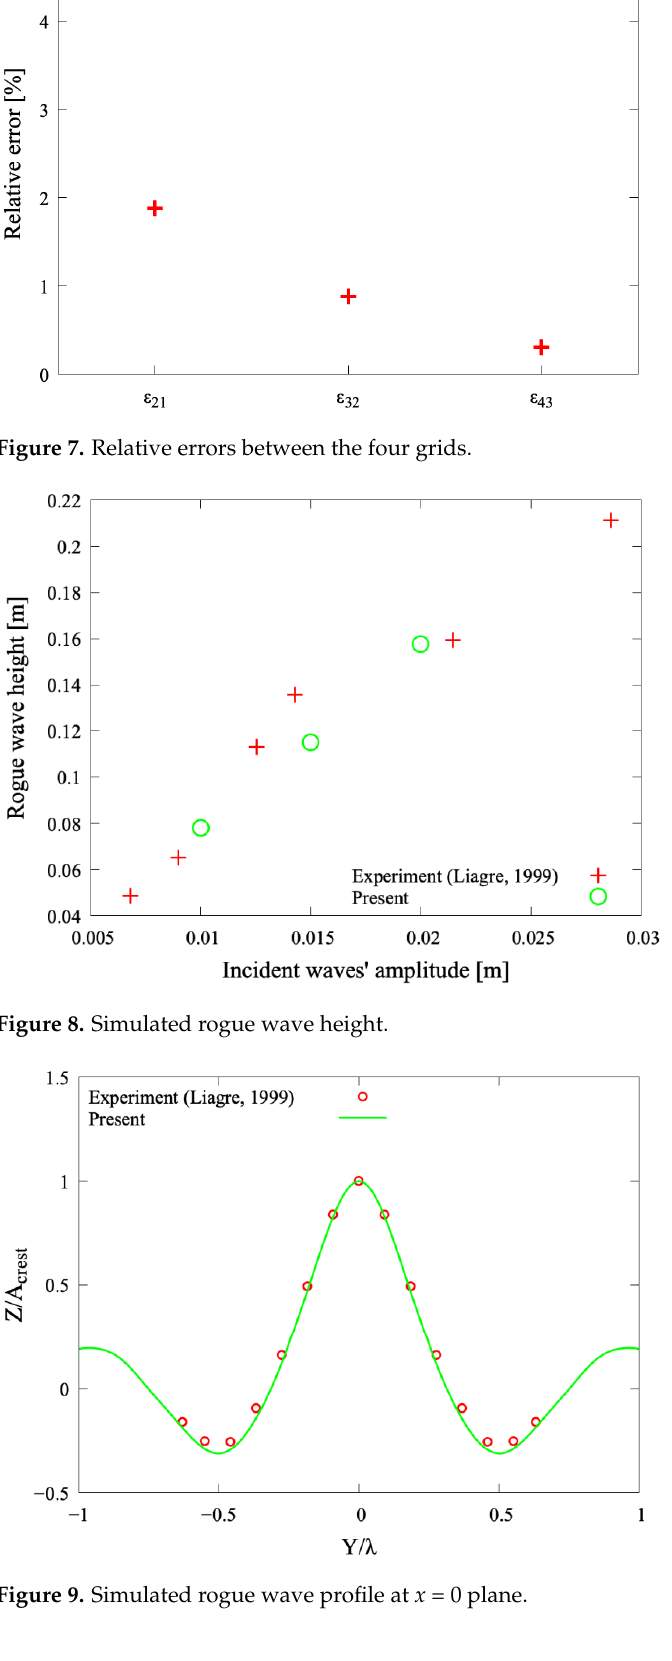
Figure 7. Relative errors between the four grids.